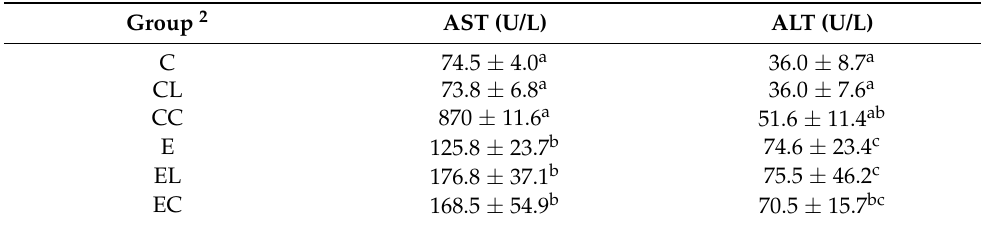
Table 4. Effects of different dietary fat sources on plasma aspartate transaminase (AST) and alanine transaminase (ALT) activities in rats 1 .